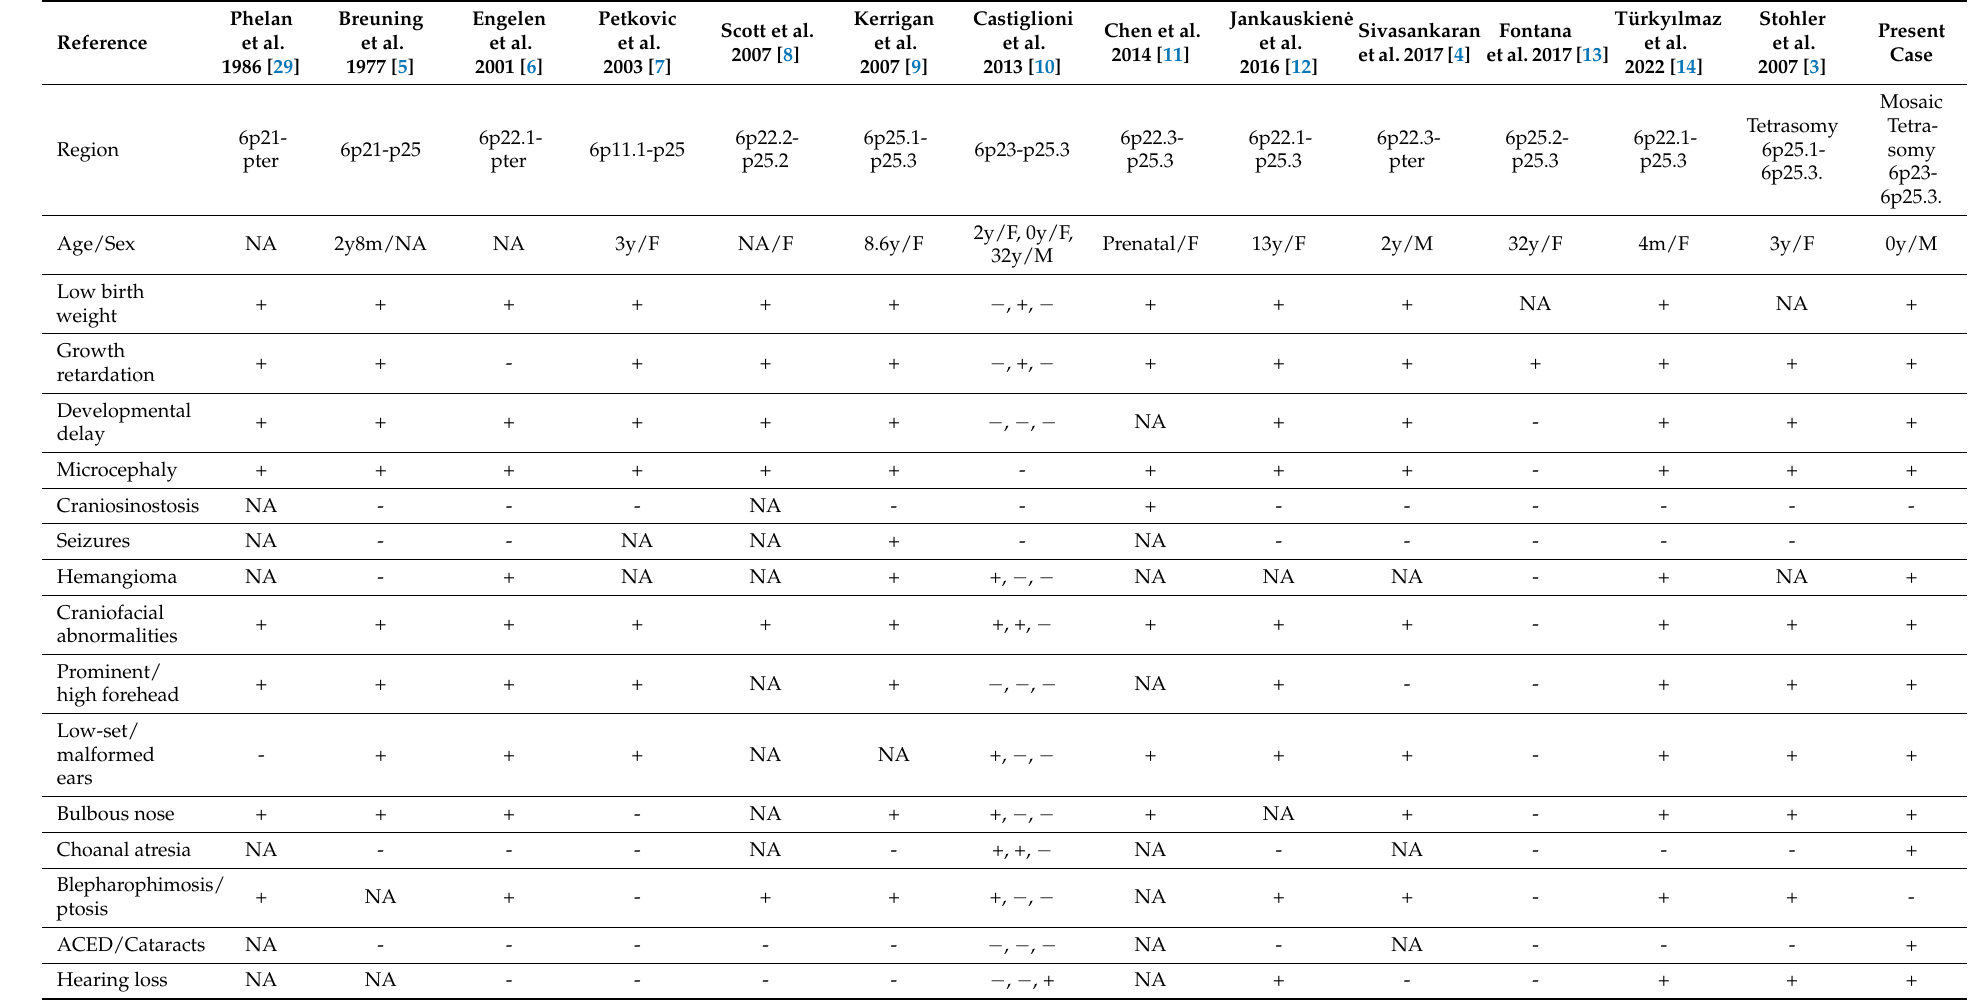
Table 3. Detailed clinical features of pure distal tri- and tetrasomy 6p patients reported in the